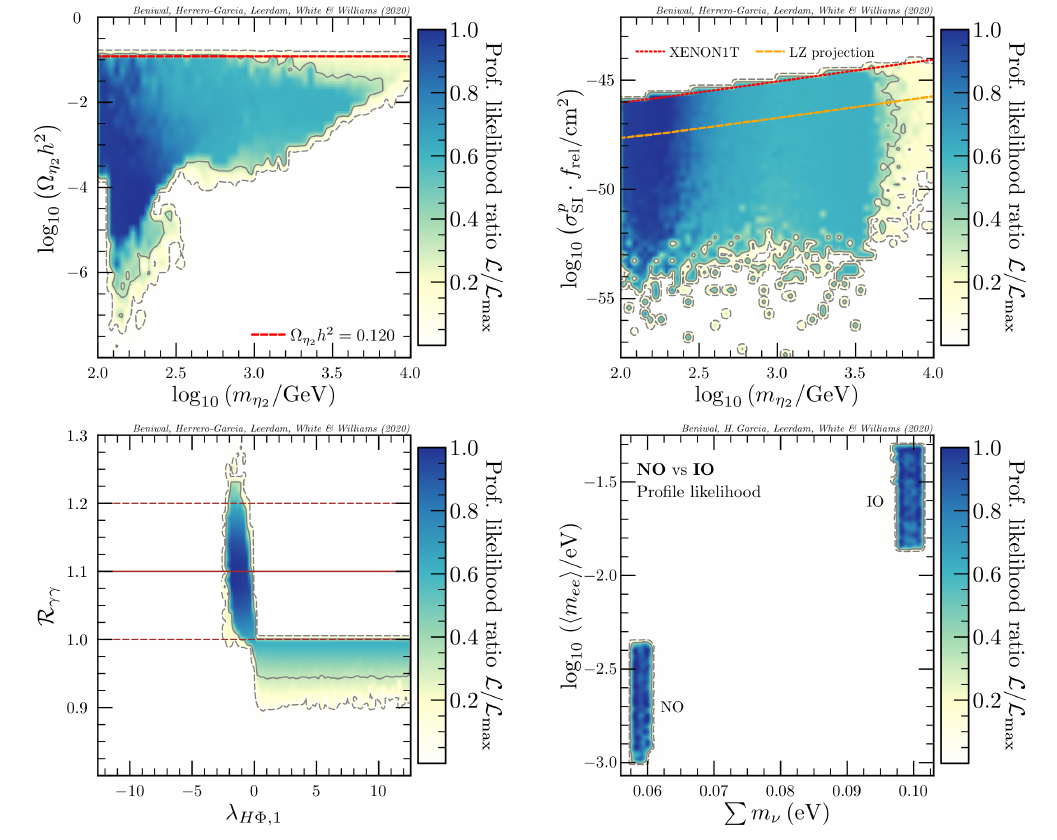
Figure 5 . 2D plots of PLR for key observables of interest. Top-left and top-right plots : same as figure 2 but for η DM with non-zero mixing. Bottom-left plot : solid (dashed) brown lines show the 2 PDG central (standard deviation) value for R of 1.1 (0.1). Bottom-right plot : h m γγ Normal Ordering (NO) and Inverted Ordering (IO); see text for more